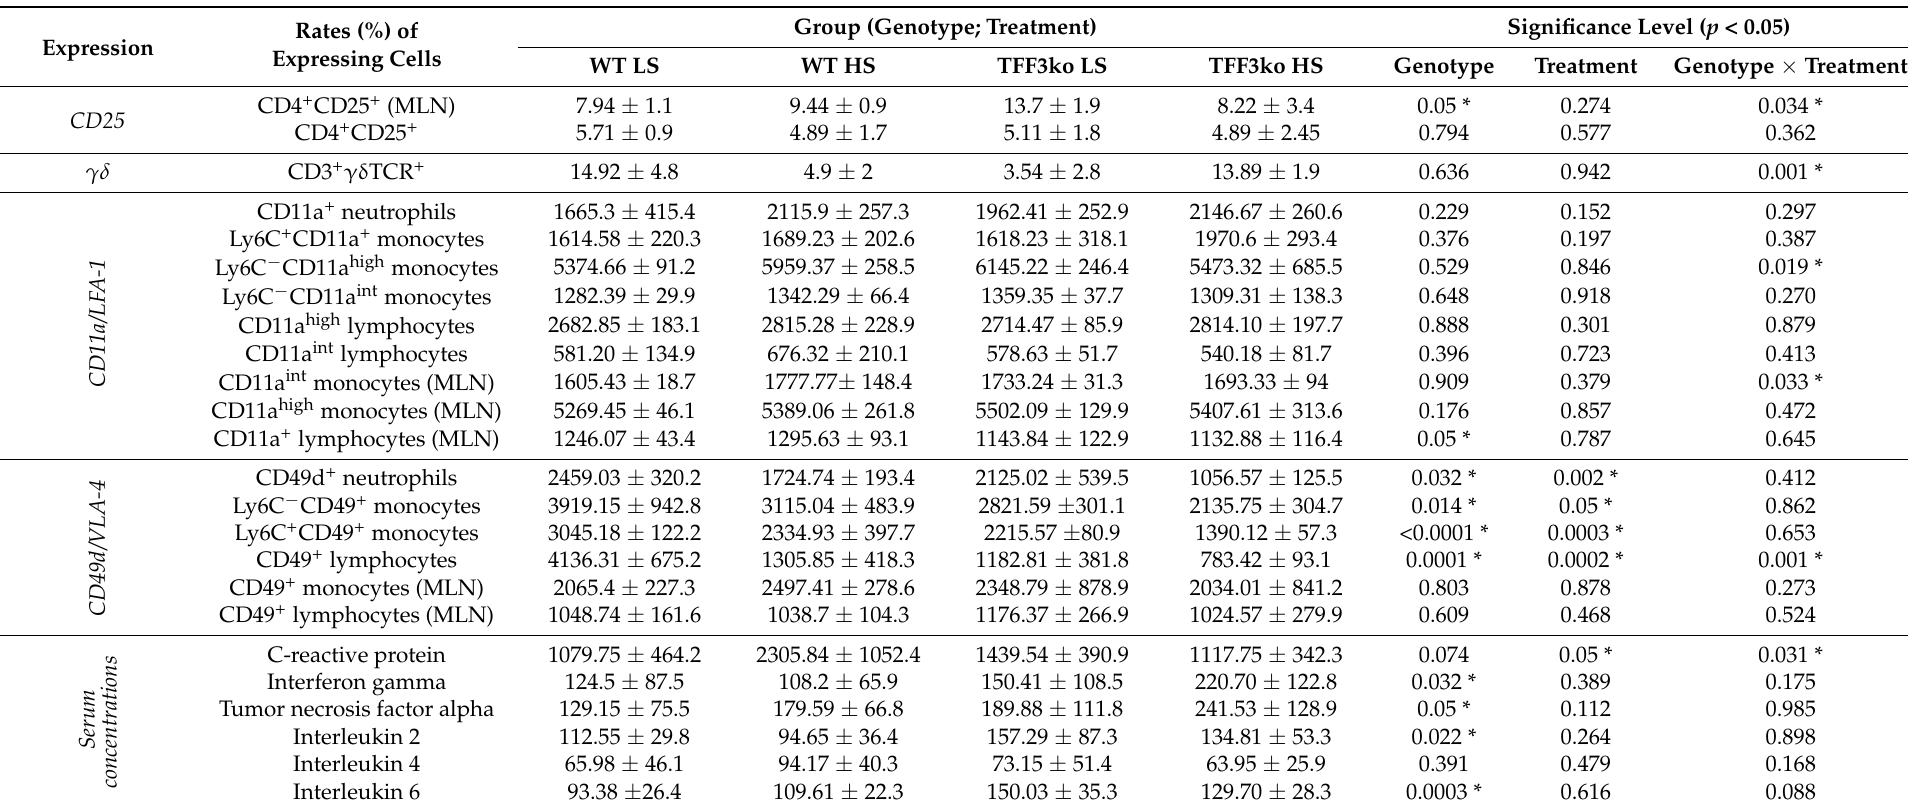
Table 1. Genotype and treatment (HS diet) interaction effects on cell adhesion molecule expression (two-way ANOVA).